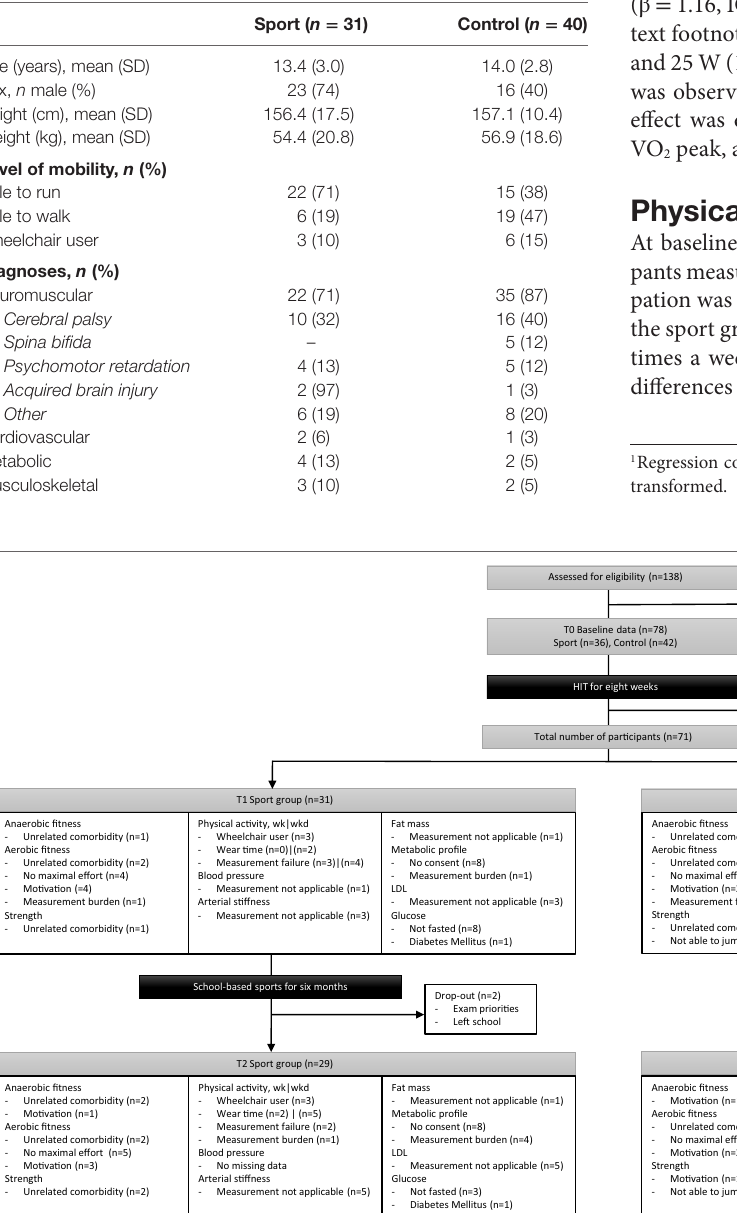
TaBlE 1 | Characteristics of participants.